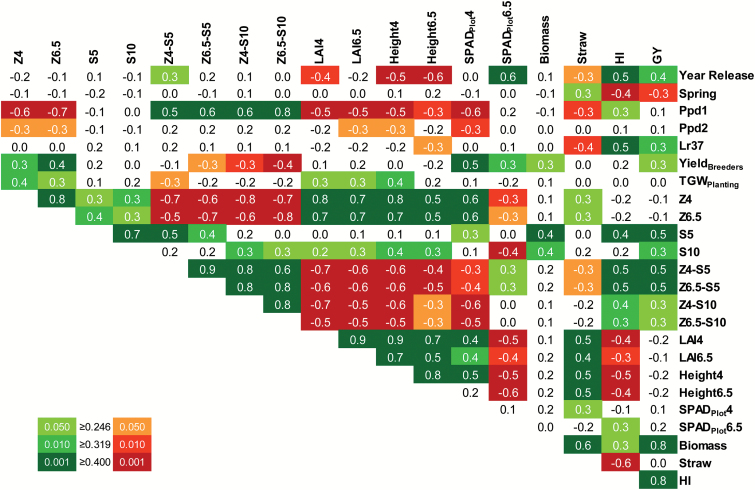
Correlation matrix showing the significance of linear correlations between paired mean values of genetic, physiological, and agronomical traits from 64 field-grown wheat cultivars. Numbers are Pearson product–moment correlation coefficients (r, df=62) and increasingly significant correlations (P≤0.05, P≤0.01, and P≤0.001) are indicated by increasingly darker shading. Year of cultivar release, spring growth habit (spring versus winter based on flowering response to temperature), presence of genes Ppd1, Ppd2, and Lr37; yield data over multiple sites and years (YieldBreeders) were kindly supplied by the authors of a previous study (Clarke et al., 2012). Measured traits are described in Table 1. (This figure is available in colour at JXB online.)